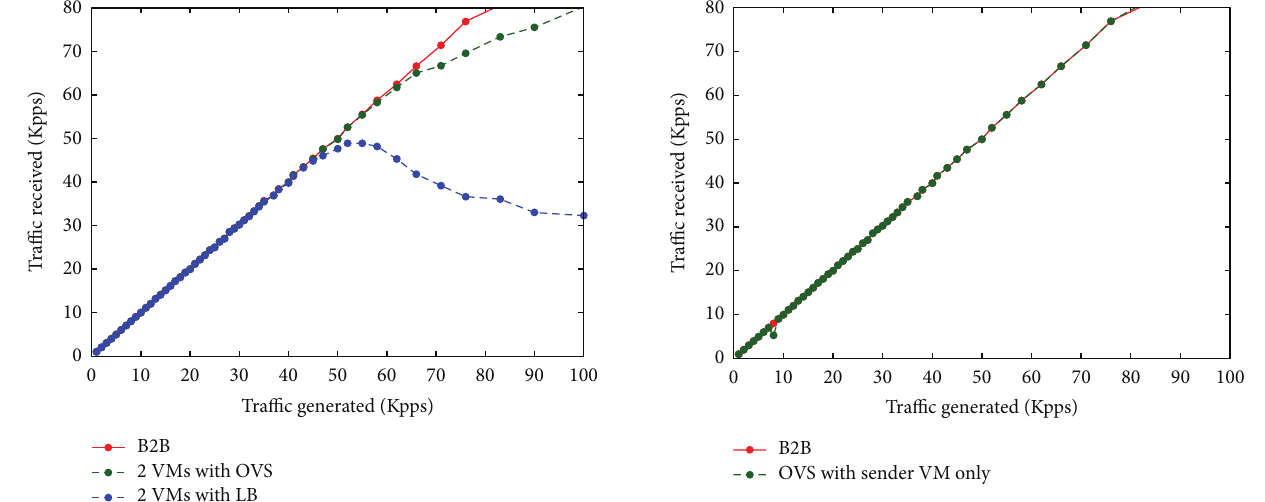
Figure 11: Received versus generated packet rate in the Non- OpenStack scenario setups (2.1) and (2.2), with 1500 -byte packets.